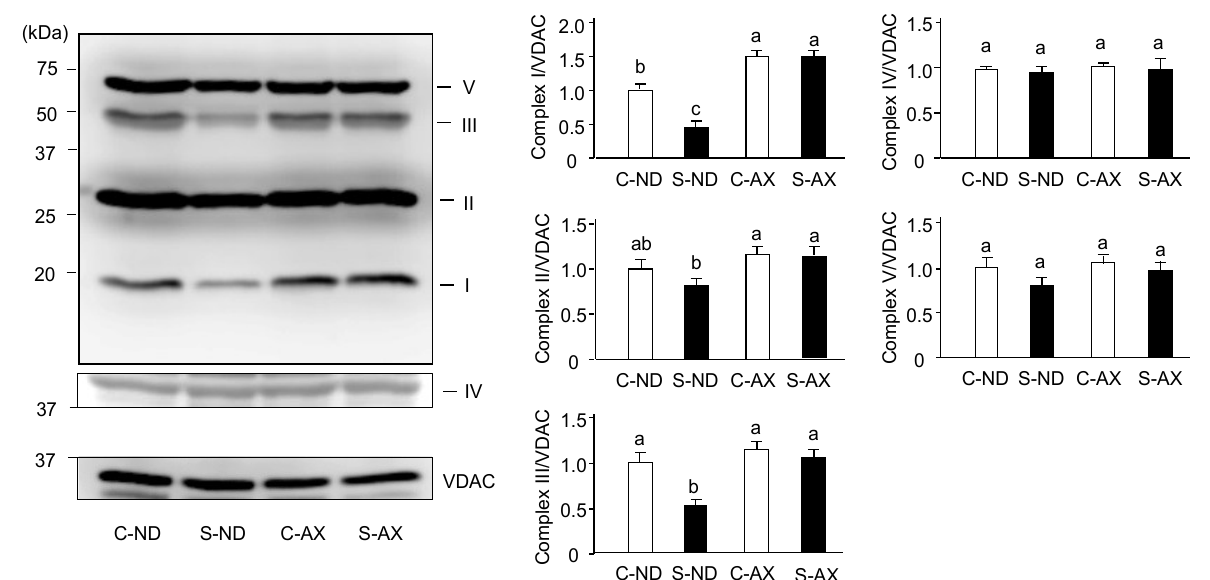
Figure 5. Effect of dietary AX on the expression of oxidative phosphorylation (OXPHOS)-related protein complexes in SO muscle of tail-suspension mice. Proteins (20 µ g/lane) were extracted from the SO muscle and subjected to SDS-PAGE and transferred onto a PVDF membrane. Immunoblotting for total OXPHOS was performed. Data are represented as mean ± S.D. ( n = 6). Different letters indicate significant differences ( p < 0.05) based on the one-way ANOVA and Tukey’s test. C-ND, control mice fed the normal diet; S-ND, tail-suspension mice fed the normal diet; C-AX, control mice fed the AX-supplemented diet; and S-AX, tail-suspension mice fed the AX-supplemented diet. Immunoblotting experiments are representative of at least three independent studies.